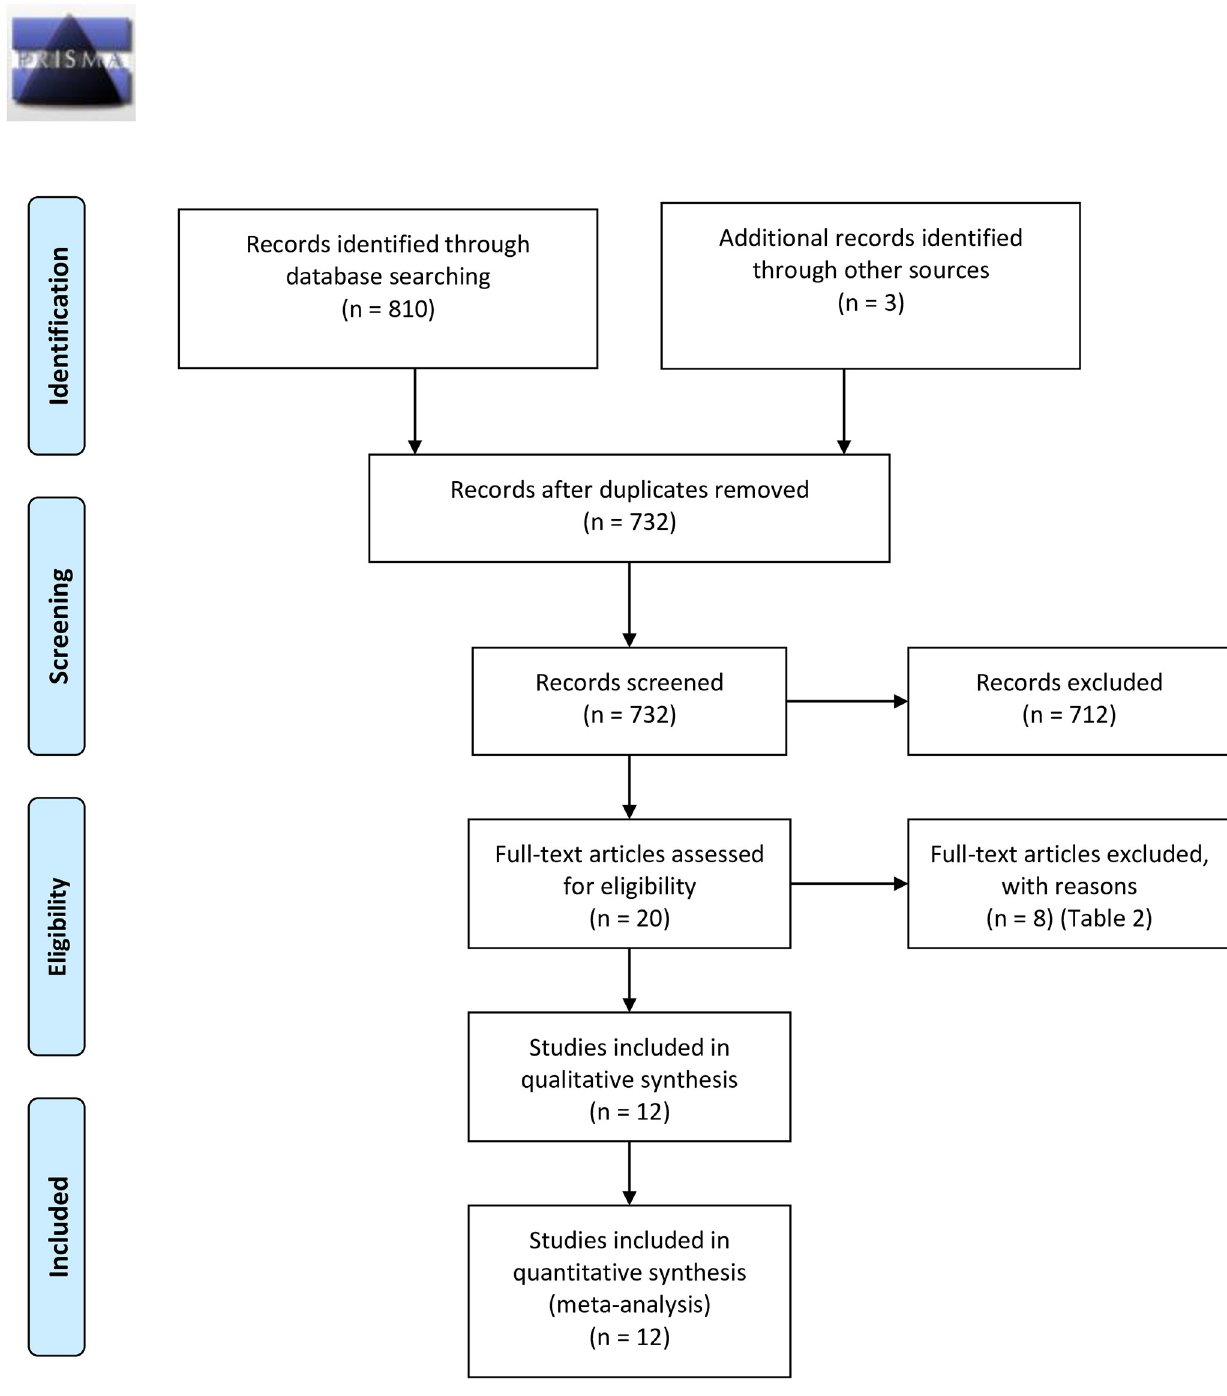
Fig 1. Study flow